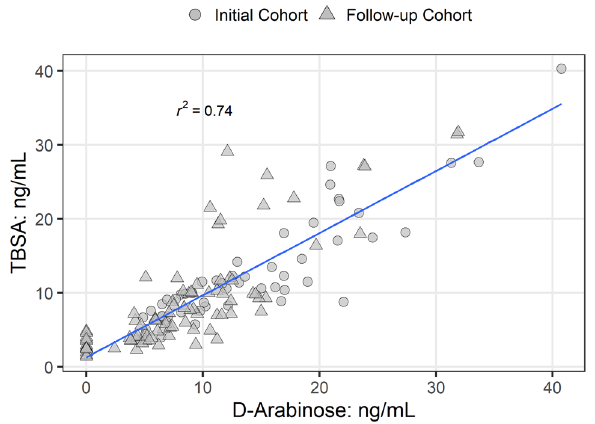
Figure 5. Correlation between d-ara and TBSA by GC/MS analysis in each urine sample